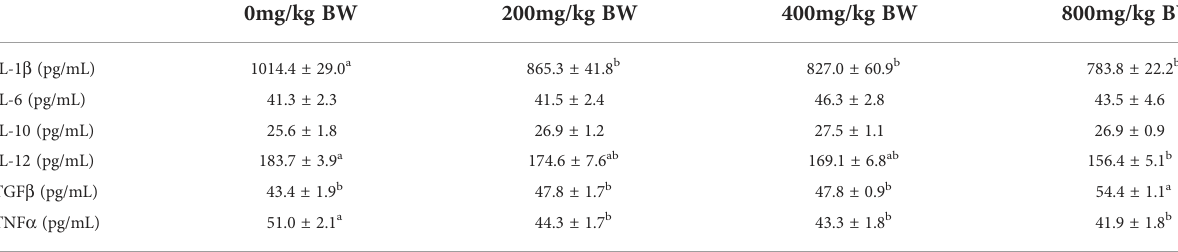
TABLE 4 Effects of tea polysaccharides on the cytokine in plasma of common